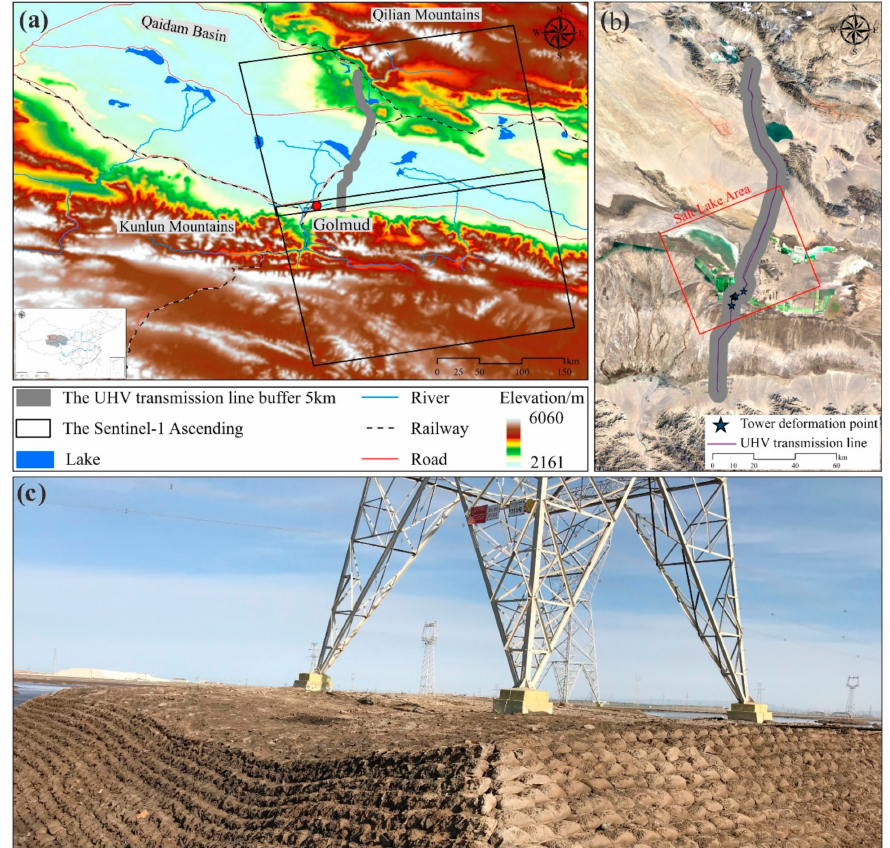
Figure 1. The geographical environment, SAR images coverage, transportation system, and de- formed tower in the study area. ( a ) the study area is outlined by a grey ribbon, ( b ) Salt Lake range, ( c ) deformed